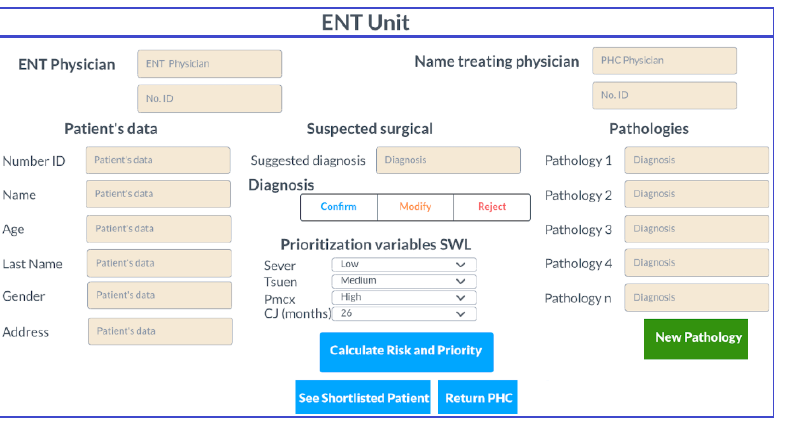
Figure 9. When the patient reaches the ENT unit, the ENT physician evaluates the patient, and confirms, modifies, or rejects the patient’s diagnosis. If he/she confirms or modifies the diagnosis, he/she completes the prioritization variables SWL and calculates the risk and priority of the